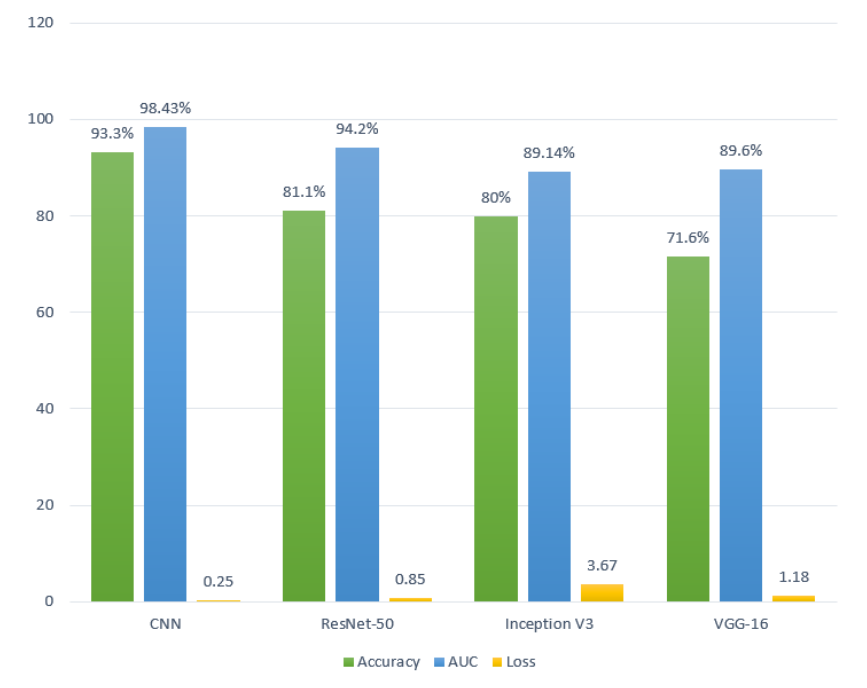
Figure 8. Performance analysis of the proposed model in terms of the accuracy, AUC, and